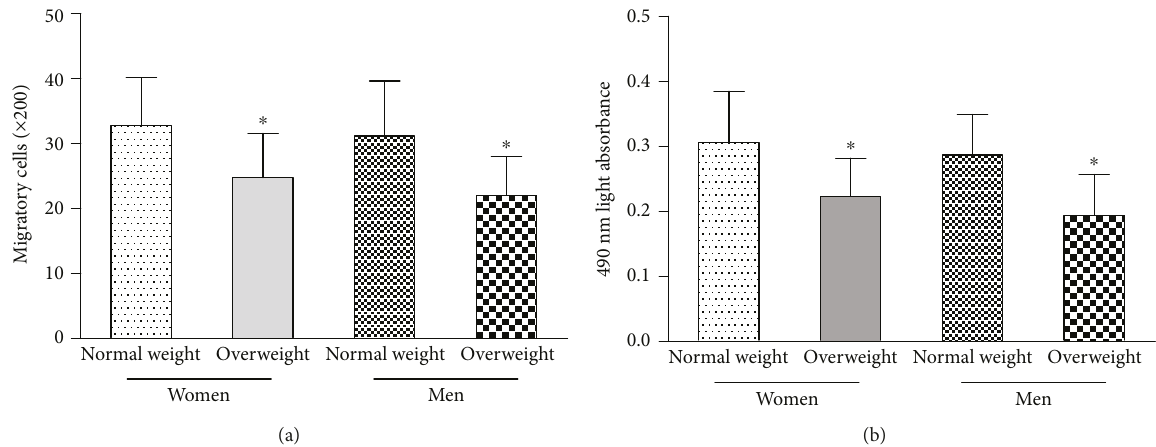
Figure 2: The activity of circulating EPCs was evaluated as follows. The migratory (a) and proliferative (b) activities of circulating EPCs in normal weight and overweight men were similar to those in normal weight and overweight postmenopausal women. EPC function was lower in overweight men and postmenopausal women than in normal weight men and postmenopausal women. Data are given as the mean ± SD. ∗ p < 0 05 versus normal